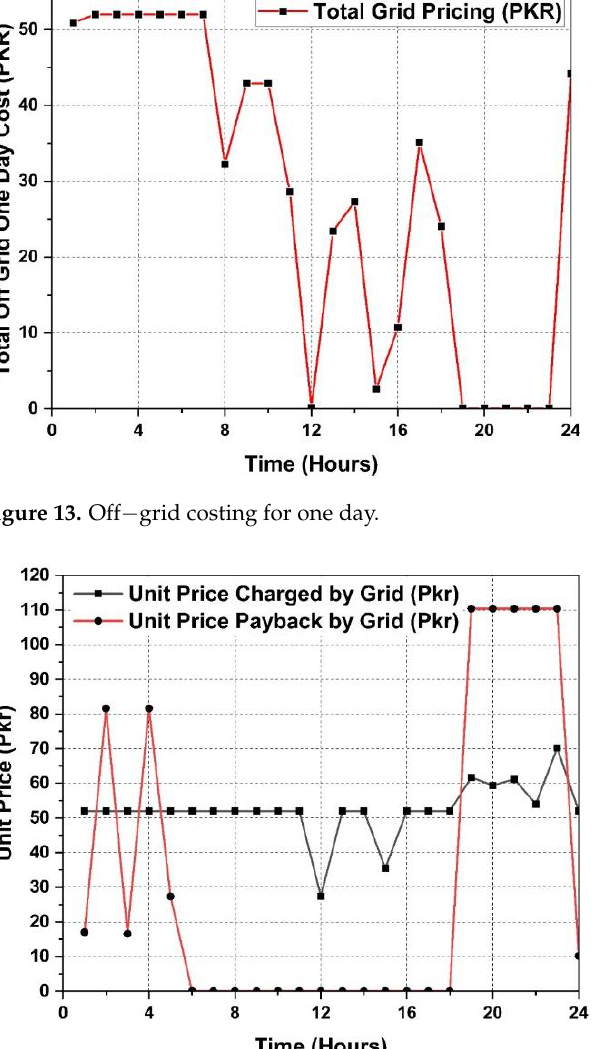
Figure 15. Monthly off − grid model costing.